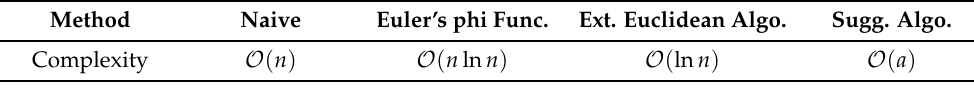
Table 1. Complexity comparison between the naive method (i.e., recursive multiplications), Euler’s phi function, extended Euclidean algorithm, and the suggested approach described by the pseudocode Algorithm 1.